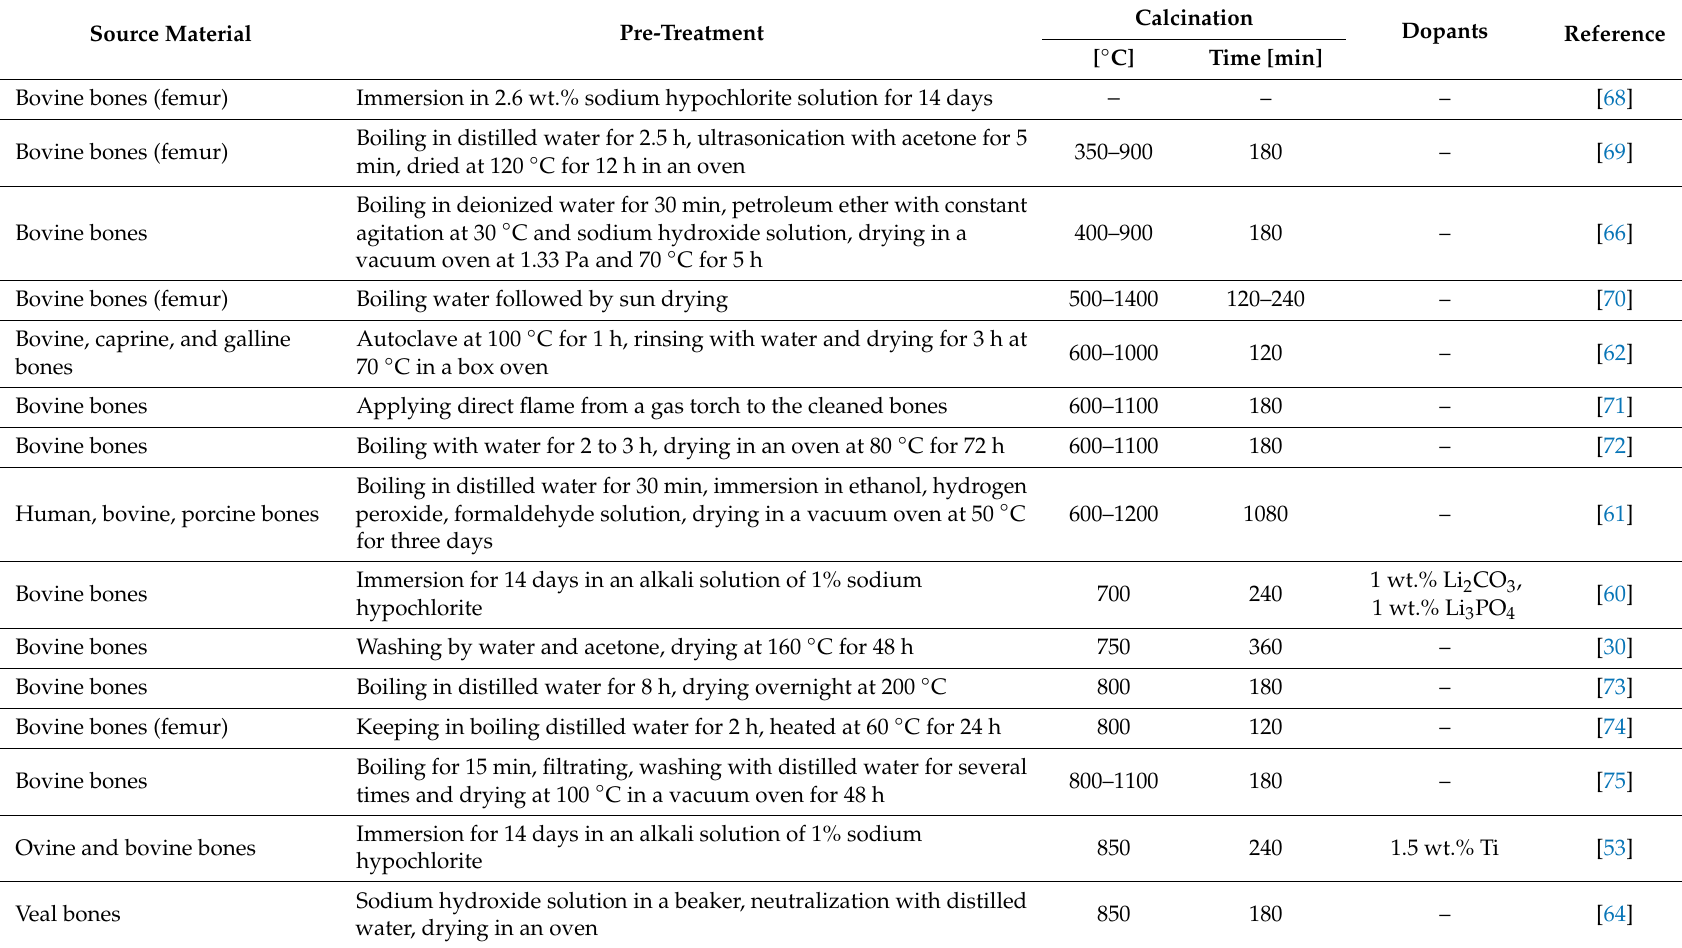
Table 3. Preparation of HA powders derived from mammalian bones, presented in the order of the calcination